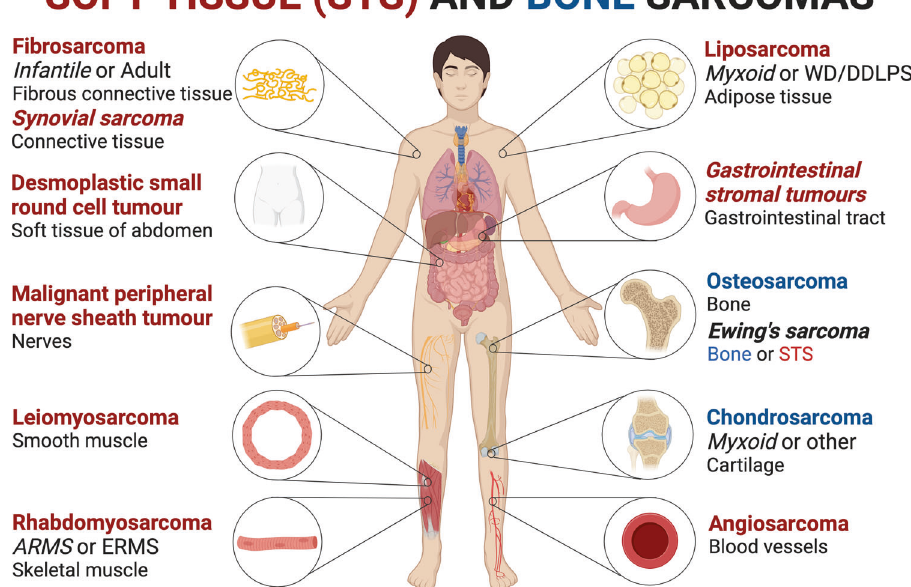
Fig. 1 Schematic representation of the most frequently occurring soft tissue (STS) (red) and bone (blue) sarcomas and affected tissues. Sarcomas with a simple karyotype are referred to in italics. ARMS alveolar rhabdomyosarcoma, ERMS embryonal rhabdomyosarcoma, WD/ DDLPS well-differentiated/dedifferentiated liposarcoma